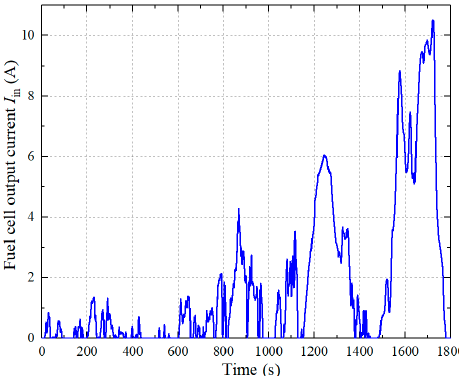
Figure 10. The fuel cell output current under the WLTP.